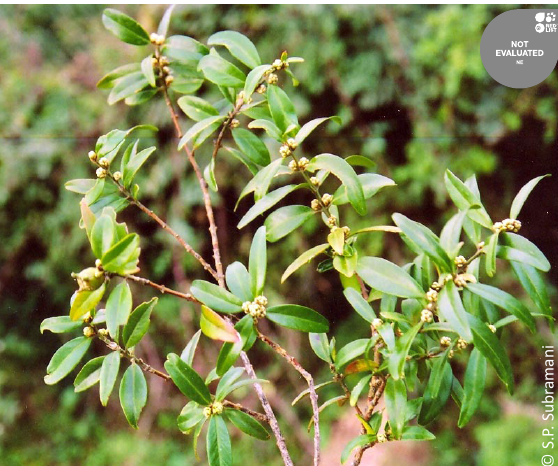
Image 36. Buxus wallichiana Baill.